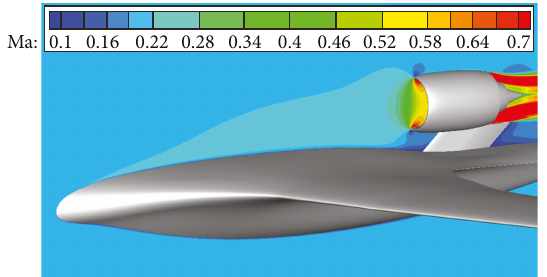
Figure 19: Airplane symmetric plane Mach number contour of powered con fi gurations at 9 ° (low speed).